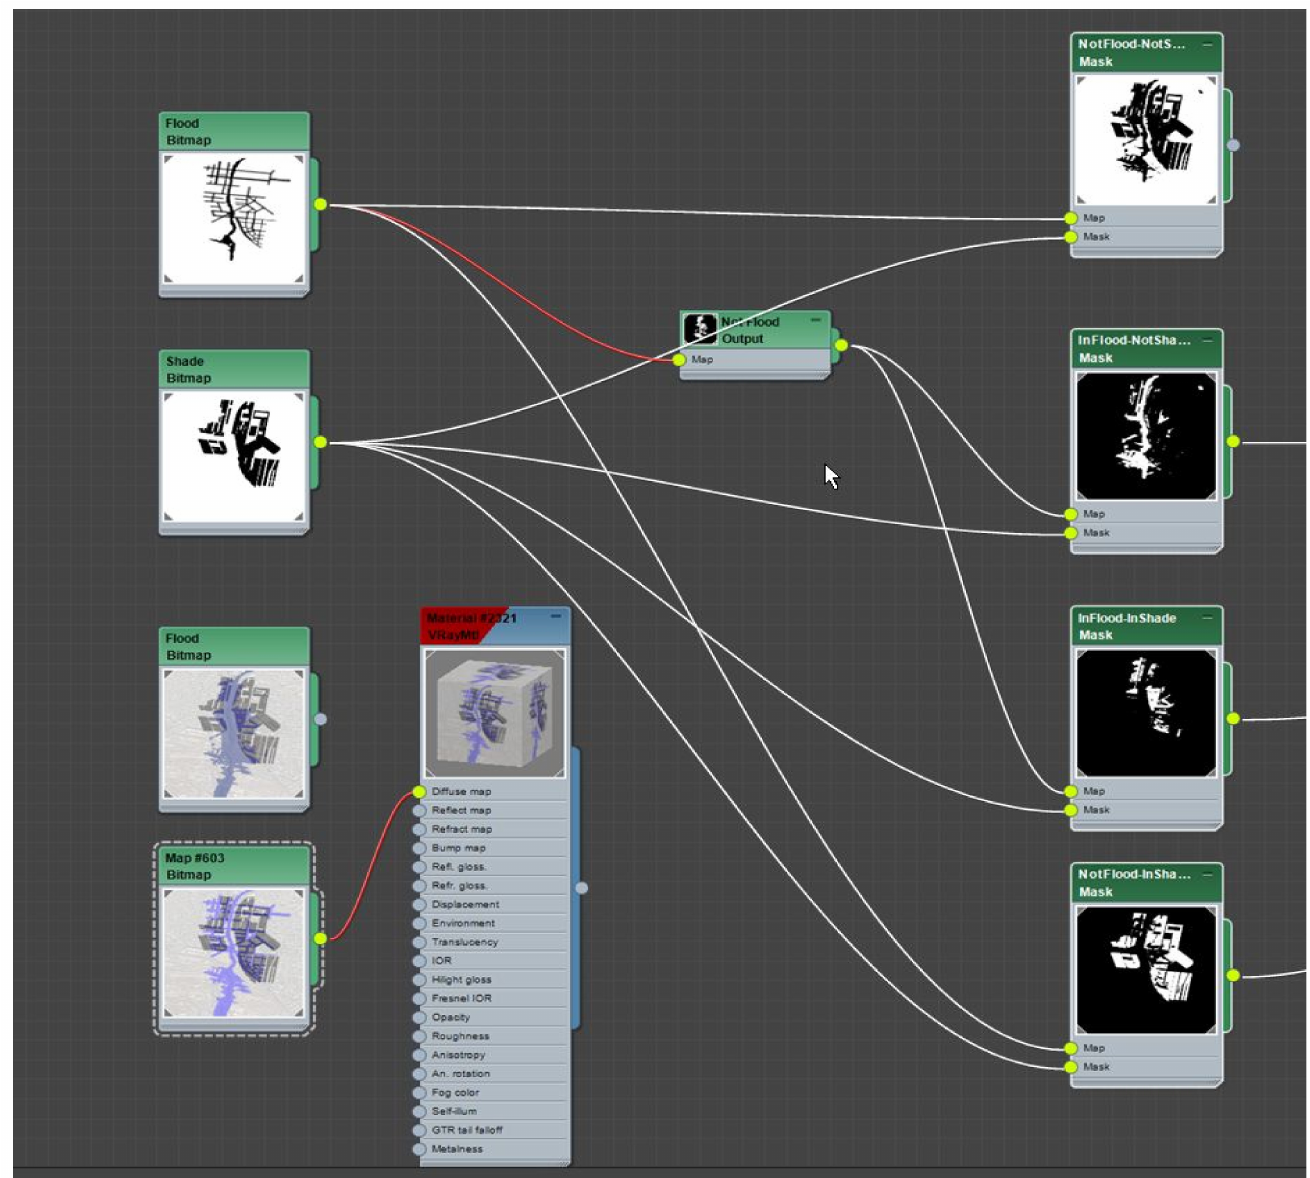
Figure 8. Conditions masking maps used to drive the suppression and occurrence of tree models within the proxy-object scattered along streets across the entire precinct. Image by authors using Autodesk™ Slate